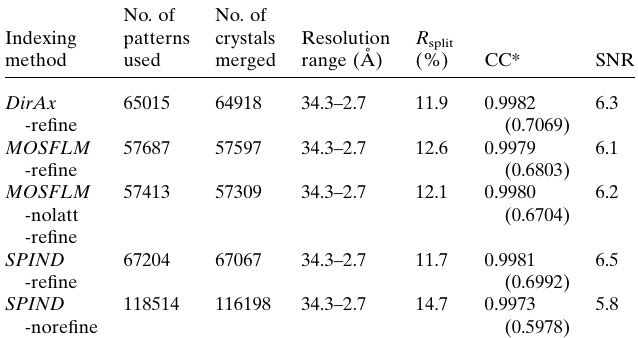
Table 3 Merging statistics from DOR SFX data using partialator . The values in the parentheses are for the highest-resolution shell (2.8–2.7 A˚